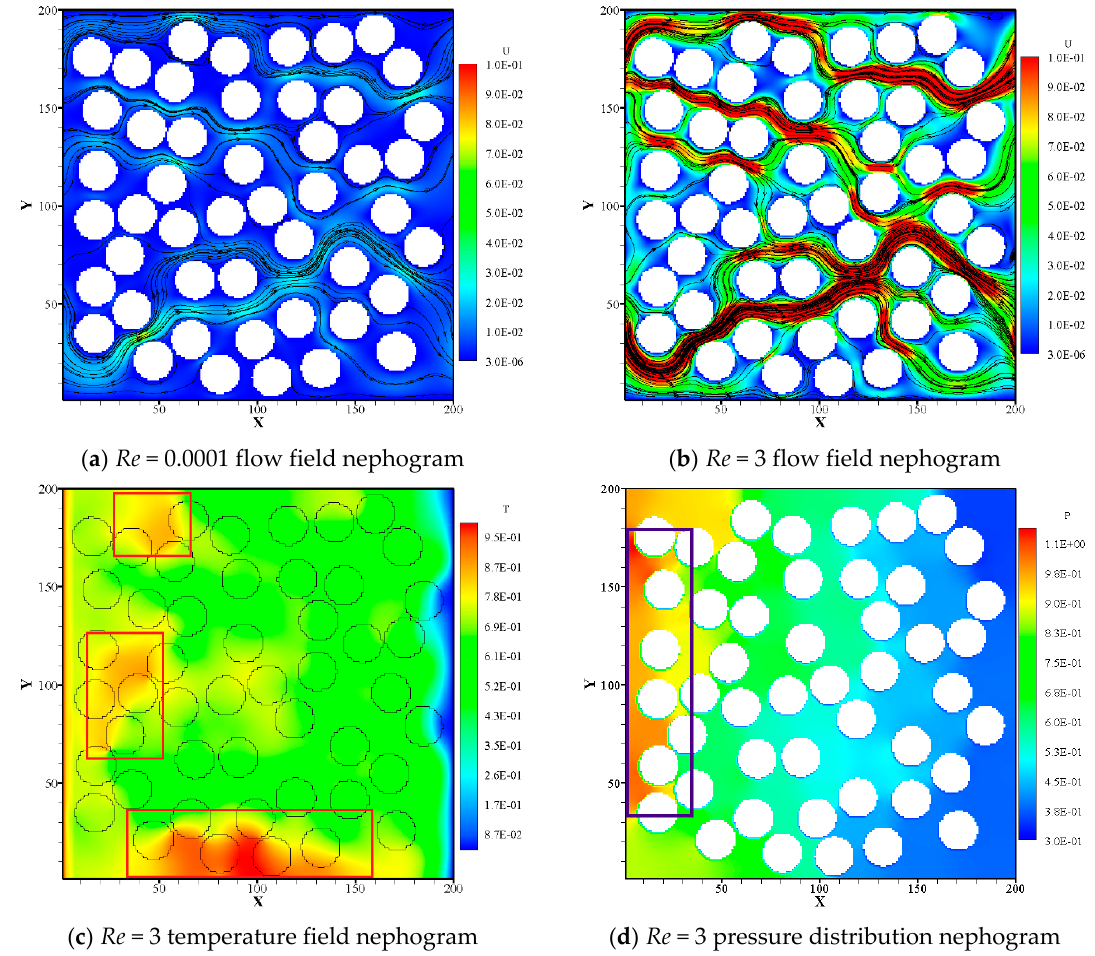
Figure 23. Nephogram of flow field, temperature field and pressure distribution in random structure.